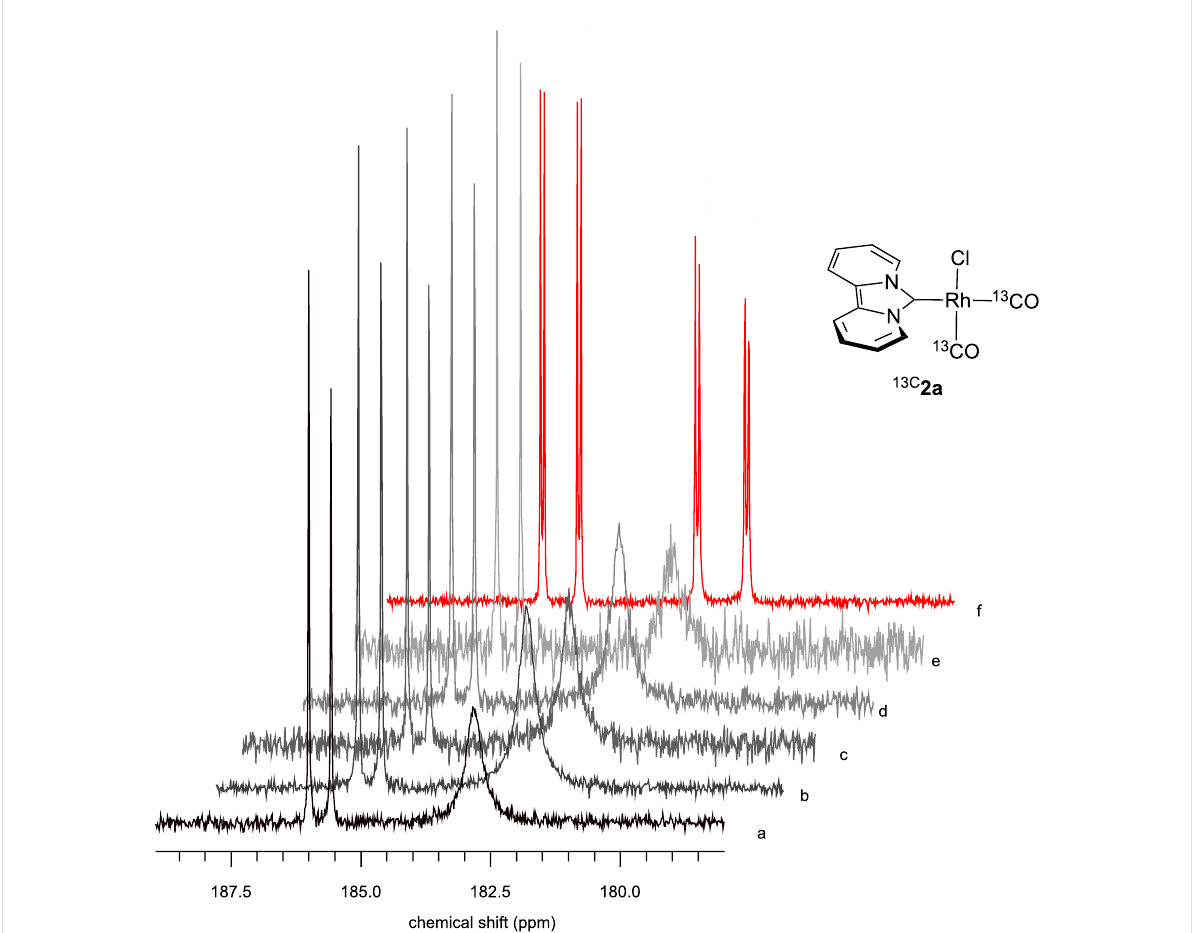
Figure 2: 13 C NMR spectra (carbonyl region, 125 MHz) of the reaction of 1a with 13 CO under variable pressure and temperature: left: a) 6 bar 13 CO, − 30 °C; b) 6 bar 13 CO, − 50 °C; c) 1 bar 13 CO, − 30 °C; d) 1 bar 13 CO, − 50 °C; e) grey: 1 bar N 2 and residual 13 CO, rt; f) red: 13 CO-free solution, rt, 75